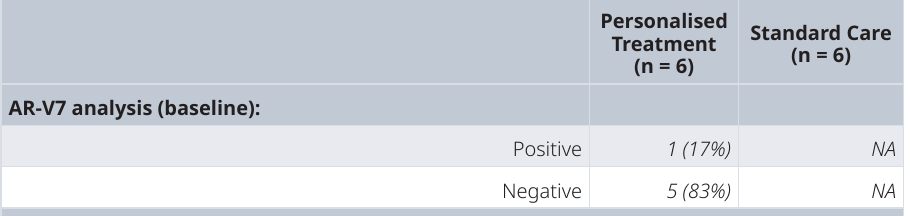
Table 2. Summary of treatment received by